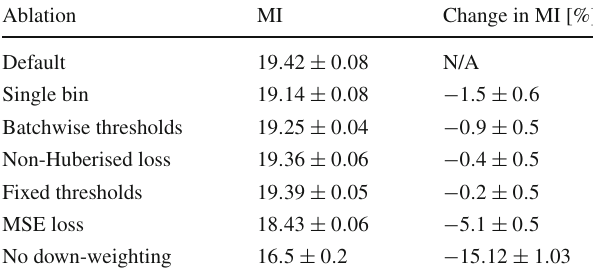
Table 2 Ablation study of the loss. The change in MI is computed as the fractional difference with respect to the default model. The “MSE” test uses the down-weighting of the data, and the “No down-weighting” test uses the full adaptive Huberised MFSE